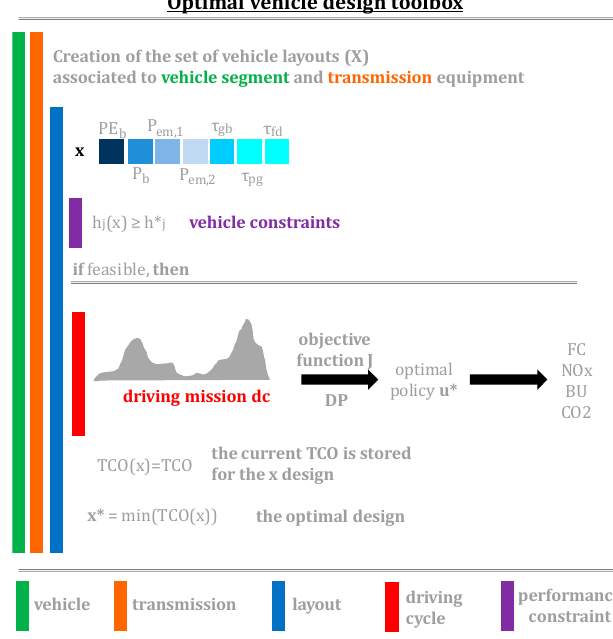
Figure 2. Scheme of the optimal vehicle design toolbox.